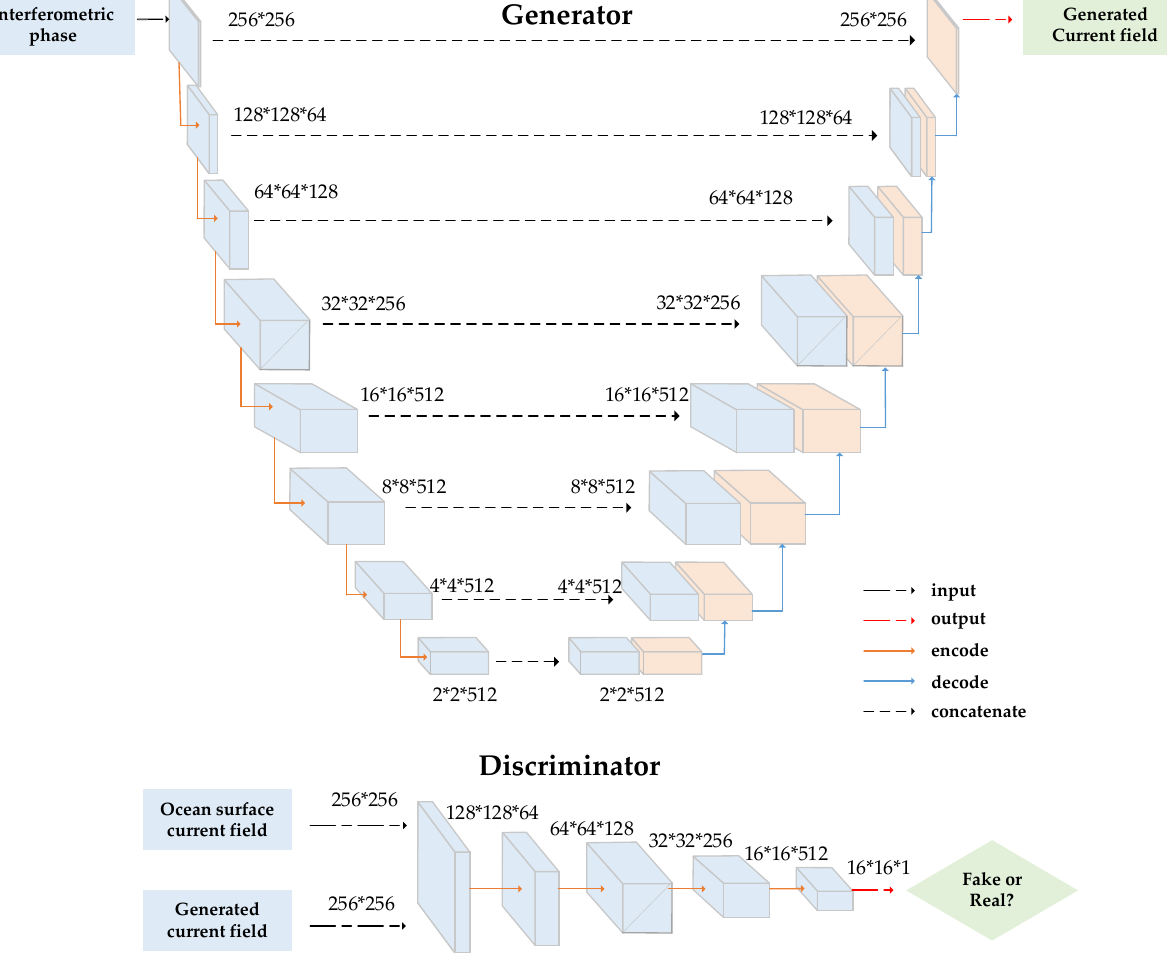
Figure 4. Basic network framework of the pix2pix model.